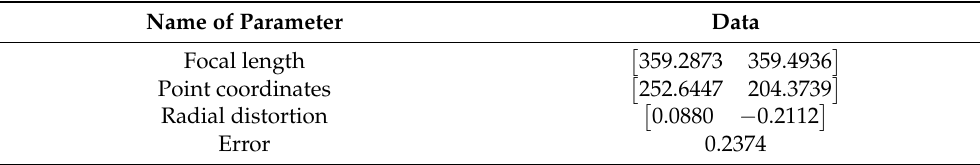
Table 1. Kinect V2 depth camera calibration internal